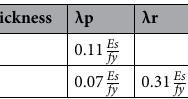
Table 6. Slenderness limits.